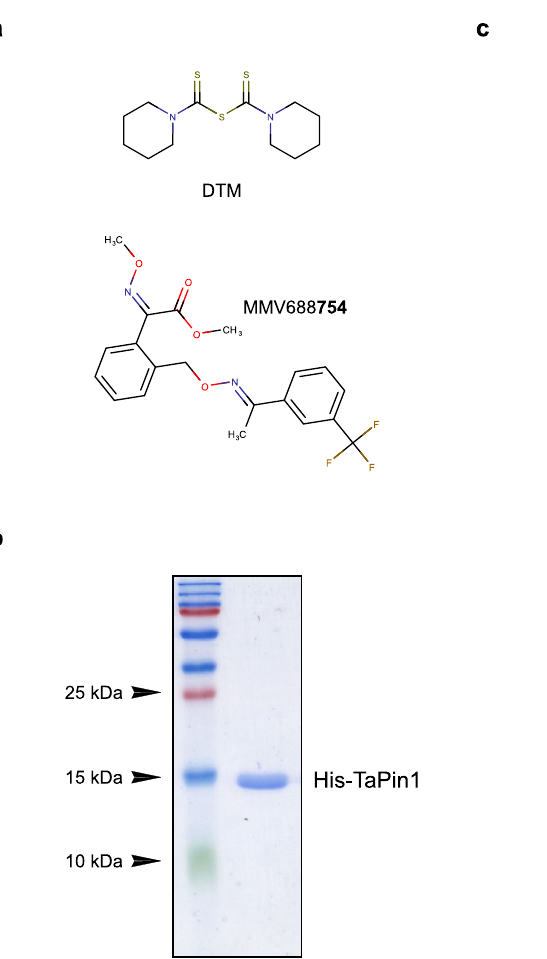
Fig. 7 MMV688754 does not inhibit TaPin1 activity. a Chemical structures of DTM (Pin1 inhibitor) and the test compound MMV688754. b Puri fi cation of recombinant His-tagged TaPin1 protein. c Inhibition assay showing that DTM alone inhibited TaPin1 prolyl-isomerase activity in vitro. TaPin1 (10 µ M) was incubated for 24 h at 4 °C degrees with 500 µ M DTM, MMV688754 or DMSO. Mixtures were diluted 1000-fold, and TaPin1 activity was assayed for 1 min by reading the absorbance at 380 nm. Apparent velocity constants (k obs ) were extrapolated from these curves. While DTM effectively inhibited TaPin1 activity, MMV688754 did not have any inhibitory effect. These results are representative of three independent experiments, which are shown quantitatively below. Mean values± SD. n = 3 independent experiments. One-way Anova statistical test followed by Dunnett ’ s multiple comparison test: **** p <